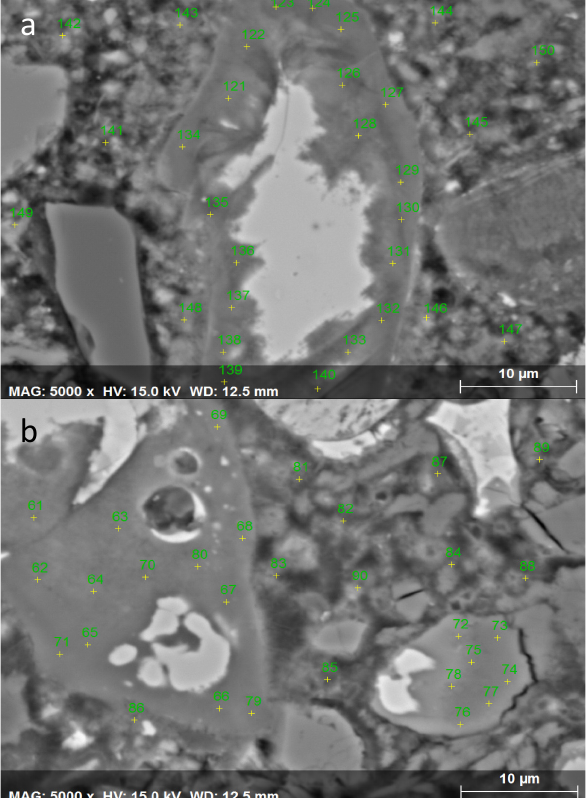
Figure 8. (a) BSE images of the 90 hydrated samples of LC 3 , and (b) SLSC .